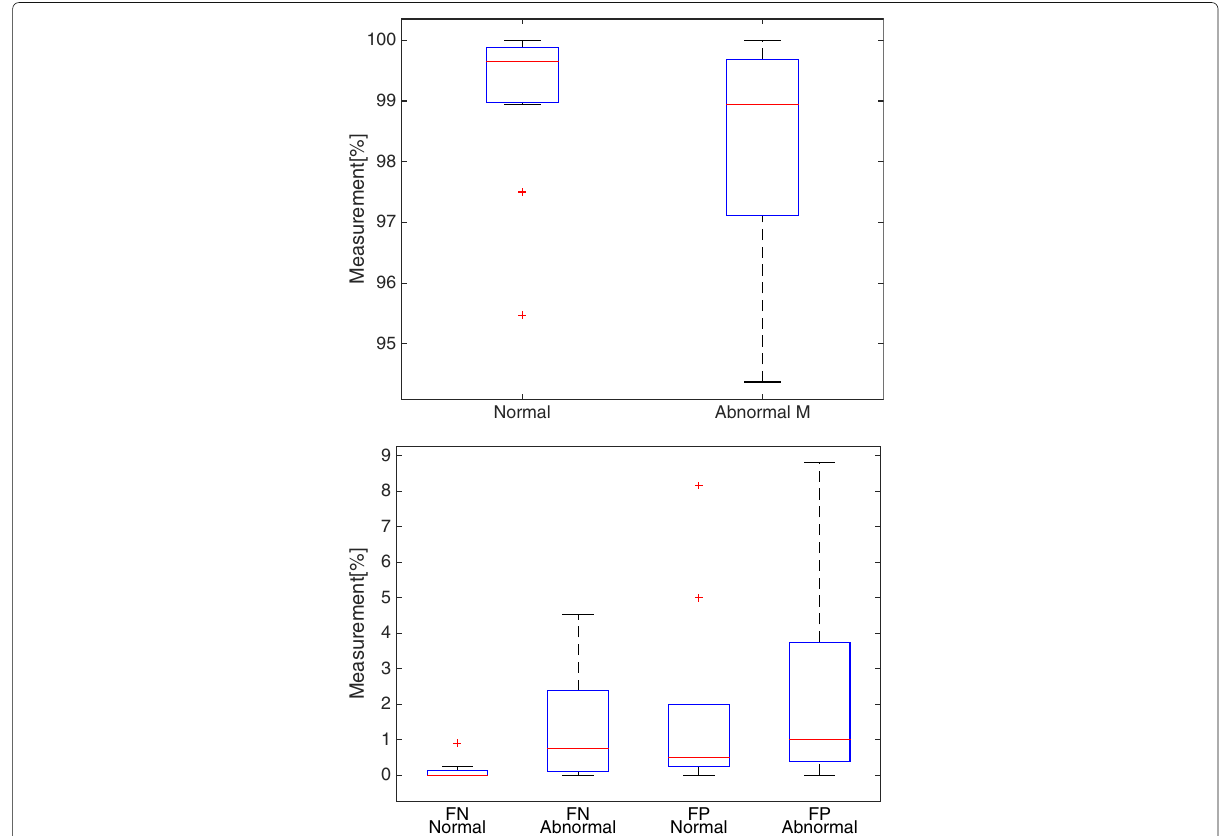
Fig. 14 Validation of ECG alteration detection. The top one shows the validation of ECG alteration detection w.r.t. BAC. The bottom one shows the validation of ECG alteration detection w.r.t. FP and FN